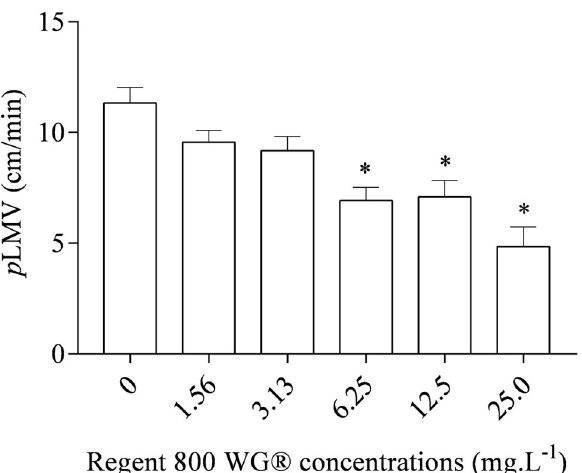
Figure 1. The p LMV of the G. tigrina , after eight days of exposure to sublethal concentrations of the Regent 800 WG ® . Concentrations refer to active ingredient of fipronil. Data are presented as mean ± standard error, n = 15. * Significant differences are observed in comparison with the control treatment (Dunnett’s post hoc test, p < 0.05).